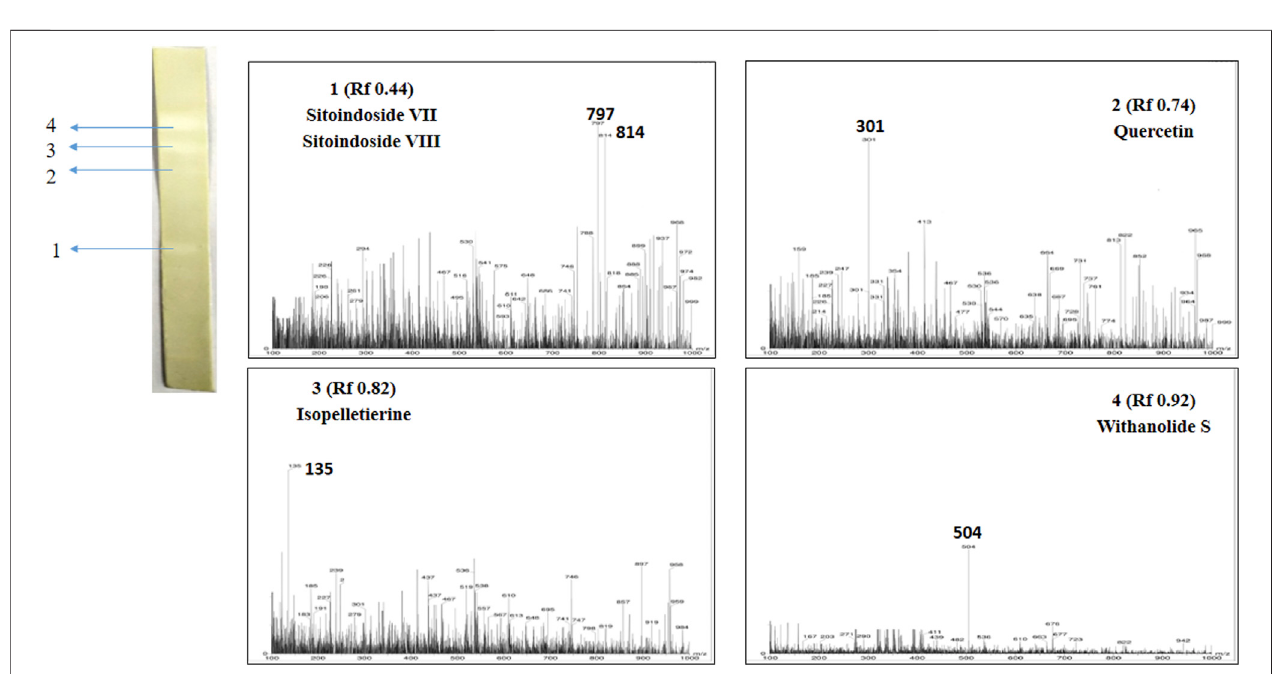
FIGURE 3 | Developed TLC-bioautography plates of WSA represents AChE active spots and their mass spectroscopy.